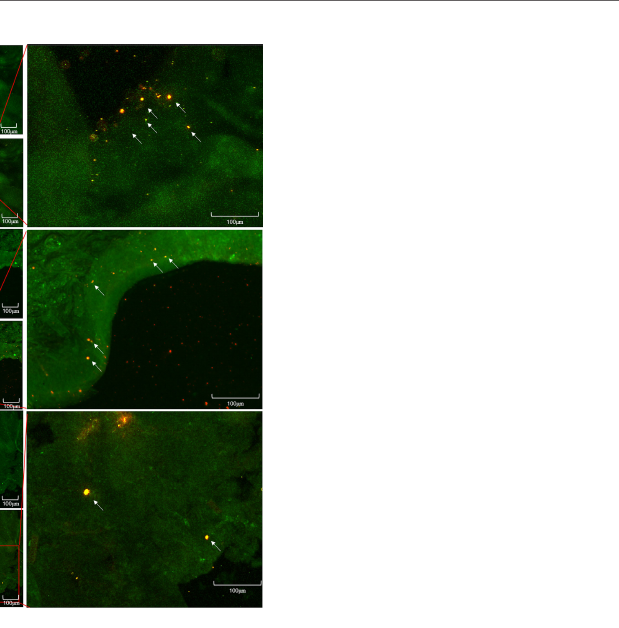
FIGURE 4 | Analysis of M cell-targeting properties. For the ileal loop test, L. lactis LL-plSAM-FVpE, SAM-FVpE or FVpE were injected into the loops. White arrows indicate co-localization signals for antigens targeting M